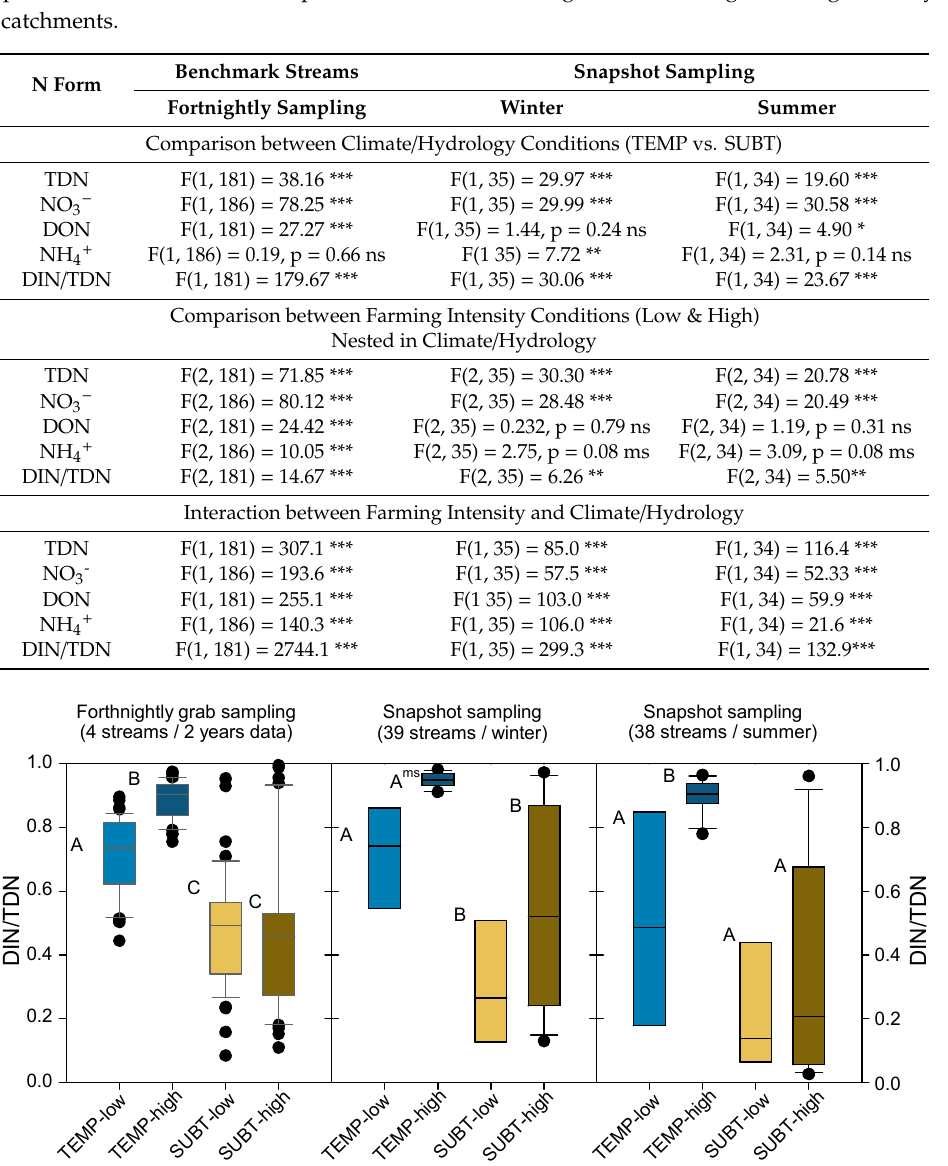
Table 4. Summary of 2-way nested ANOVA tests for the concentration of N forms, indicating the origin (sampling method) of the data. Above: Main e ff ects of climate / hydrology conditions (two levels). Below: Main e ff ects of farming intensity (two levels: low- and high-intensity farming) nested within climate / hydrology conditions and interaction between factors. F values and the respective degrees of freedom are indicated. Significance level: P > 0.1 ns, 0.05 < P < 0.1 ms, P < 0.05 *, P < 0.01 **, P < 0.001